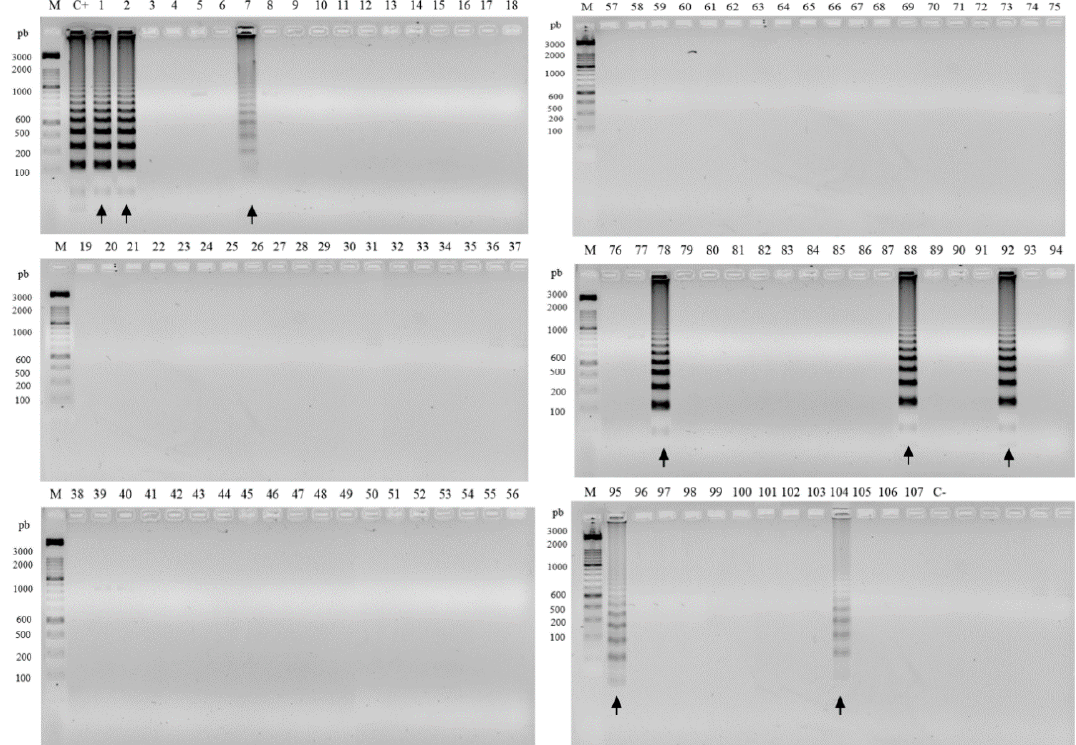
Figure 3. Positive environmental samples for FOP by RCA screening. Molecular marker 1 kb. C+, positive control F. pedrosoi (CBS 271.37); C-, negative control F. erecta (CBS125760). Bacabeira: 1–5,